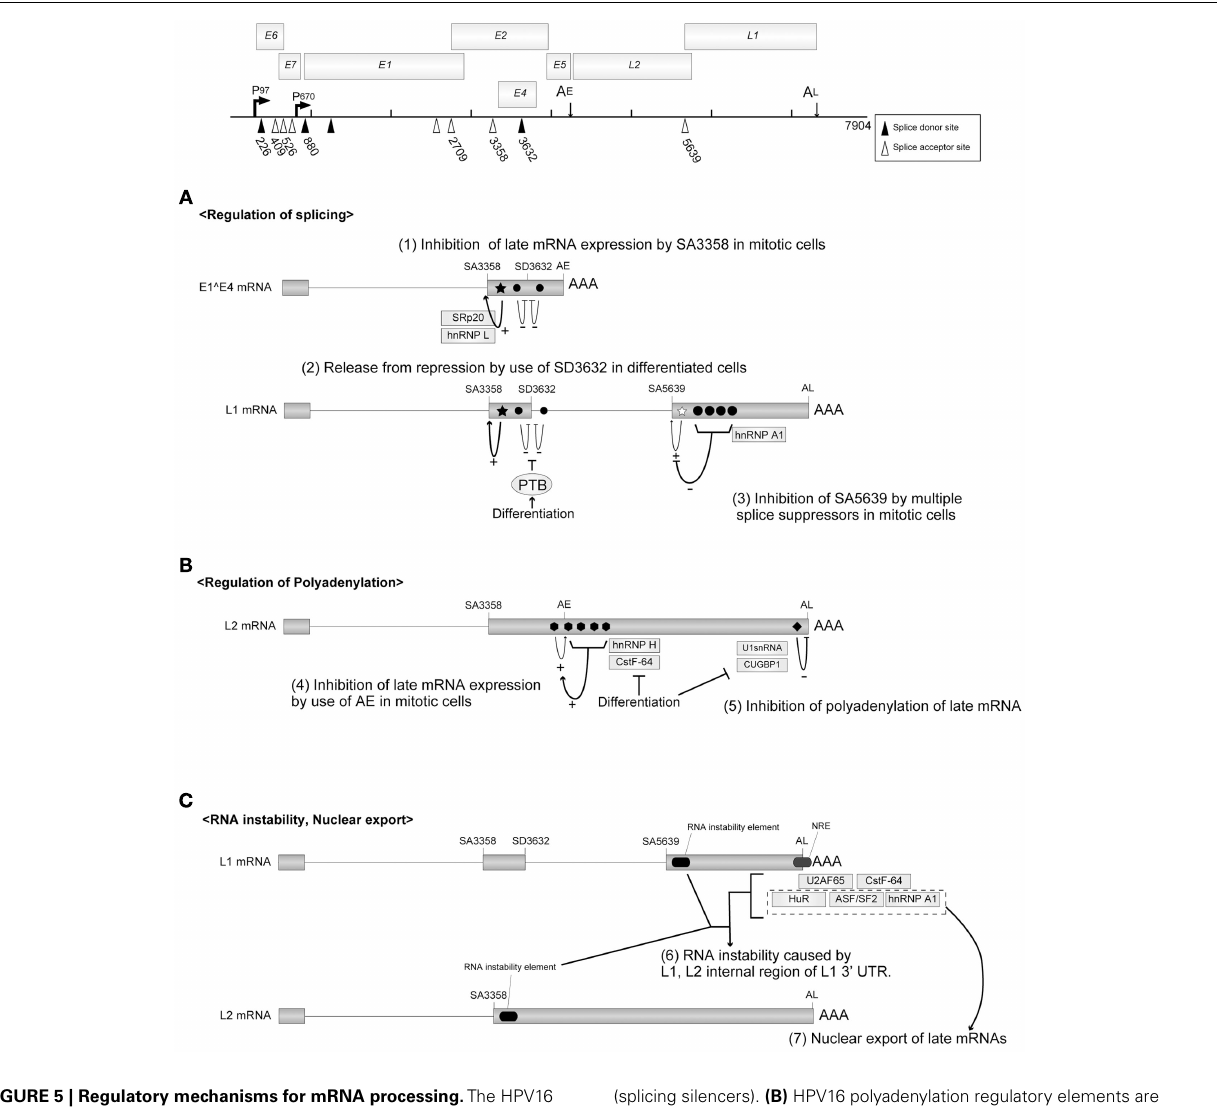
FIGURE 5 | Regulatory mechanisms for mRNA processing. The HPV16 genome with the promoters, the poly(A) signals, and the splicing signals are shown at the top of the figure. Open triangles indicate splicing acceptors and filled triangles indicate splicing donors. (A) HPV16 splicing regulatory elements are indicated as filled stars (splicing enhancers) or filled circles